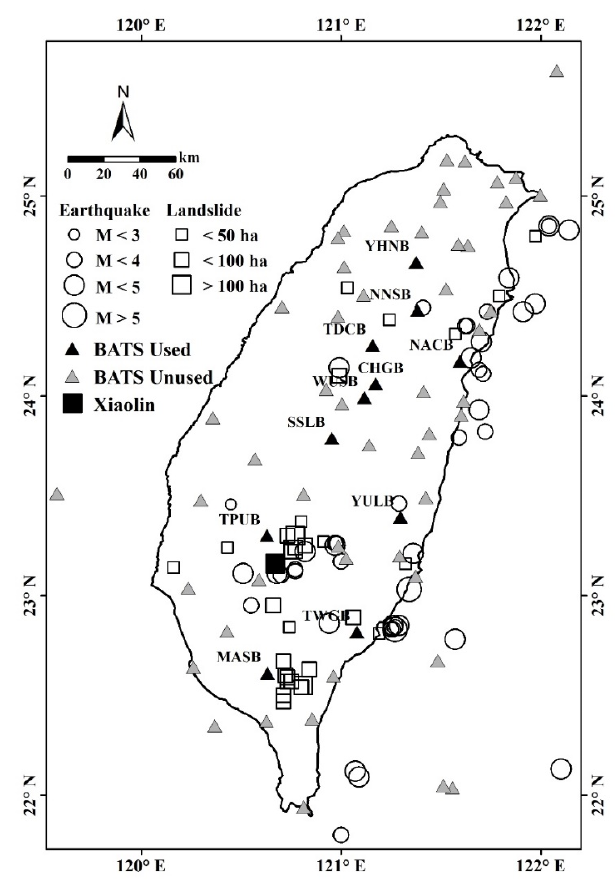
Figure 1. Map showing the locations of the BATS stations, landslides and earthquakes that were used to make the machine learning classifier.